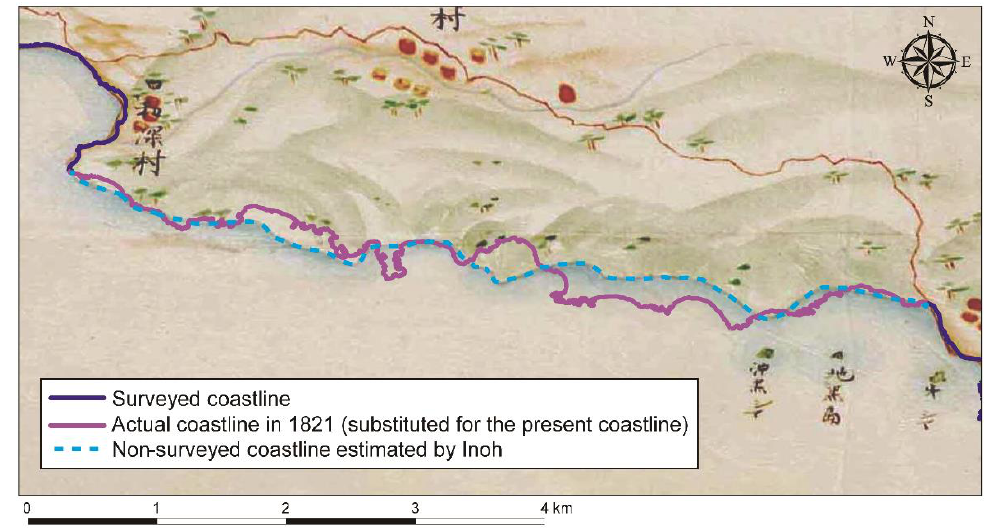
Figure 4. Example of a non-surveyed (estimated) coastline. The crimson line indicates the survey line corresponding to the road. Source: Digital Inoh’s Map and GSI map.